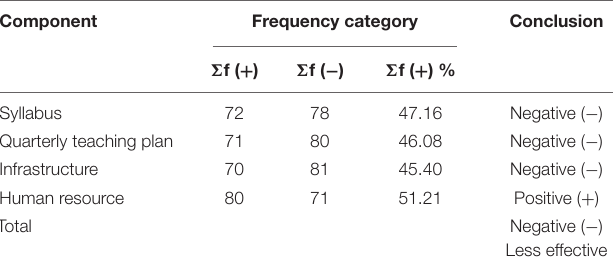
TABLE 4 | T -score analysis of the input variable component.